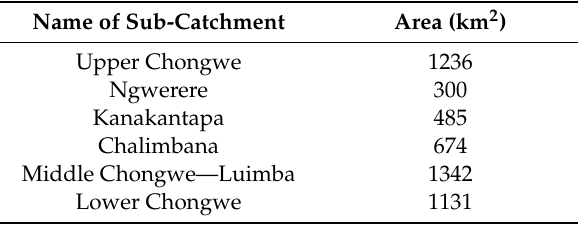
Table 1. Sub-catchments of Chongwe River